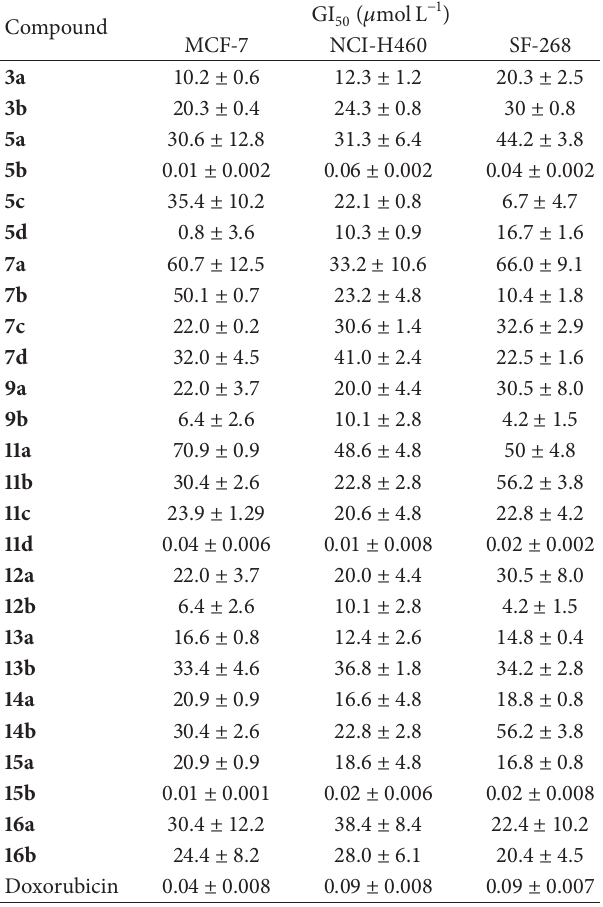
Table 3: Effect of compounds 3a,b – 15a,b on the growth of three human tumor cell